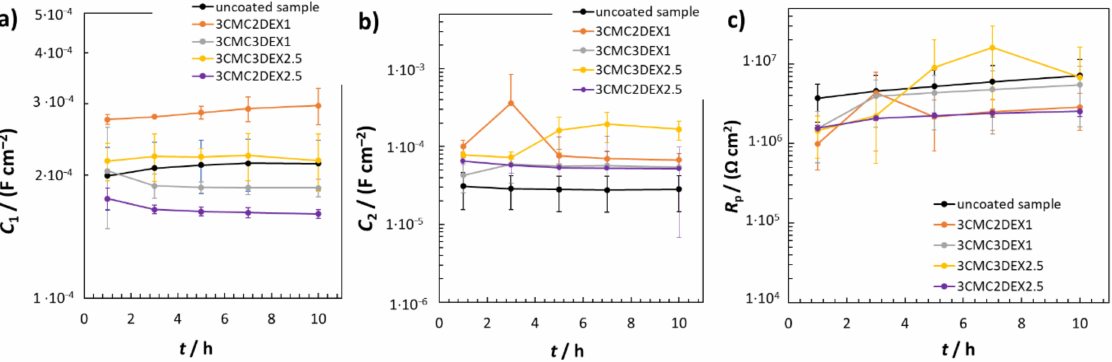
Figure 6. EIS fitted data for uncoated and coated samples; ( a ) C 1 , ( b ) C 2 , and ( c ) R p fitted values obtained using R Ω ( Q 2 ( R 2 ( Q 1 R 1 )))